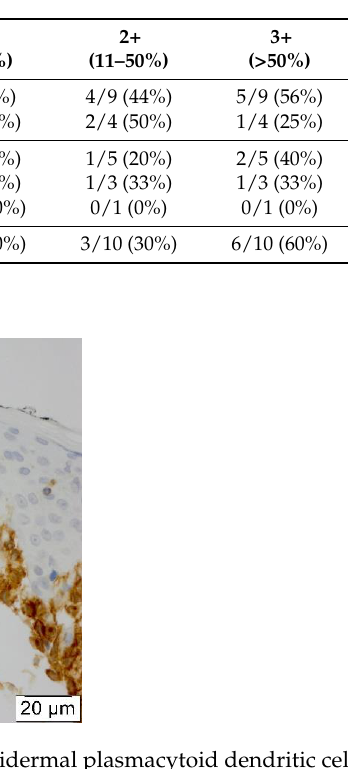
Table 1. This table shows percentage of the pDCs in the dermal inflammatory infiltrate in relation to different etiologic categories as well as their epidermal involvement.